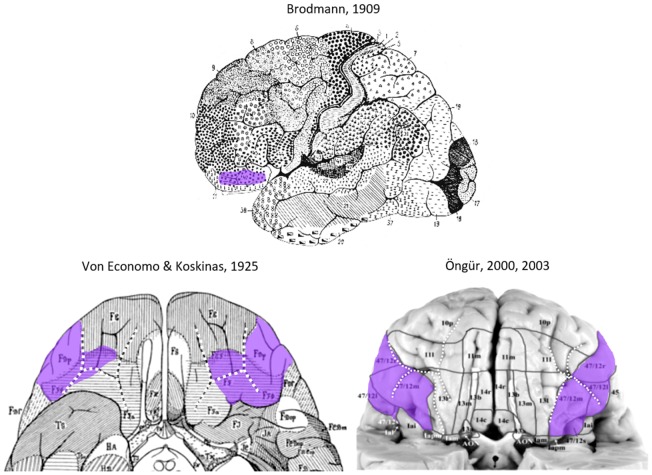
Area 47 in the lateral orbitofrontal cortex (lateral OFC) in the human brain according to previous cytoarchitectonical analyses(Brodmann, 1909; von Economo and Koskinas, 1925; Von Economo, 1929; Öngür et al., 2003). The sulcal pattern is highlighted with white dotted lines. Images have been modified such that the sulcal patterns are highlighted with white dotted lines, and the approximate extent of Area 47 is labeled in purple.